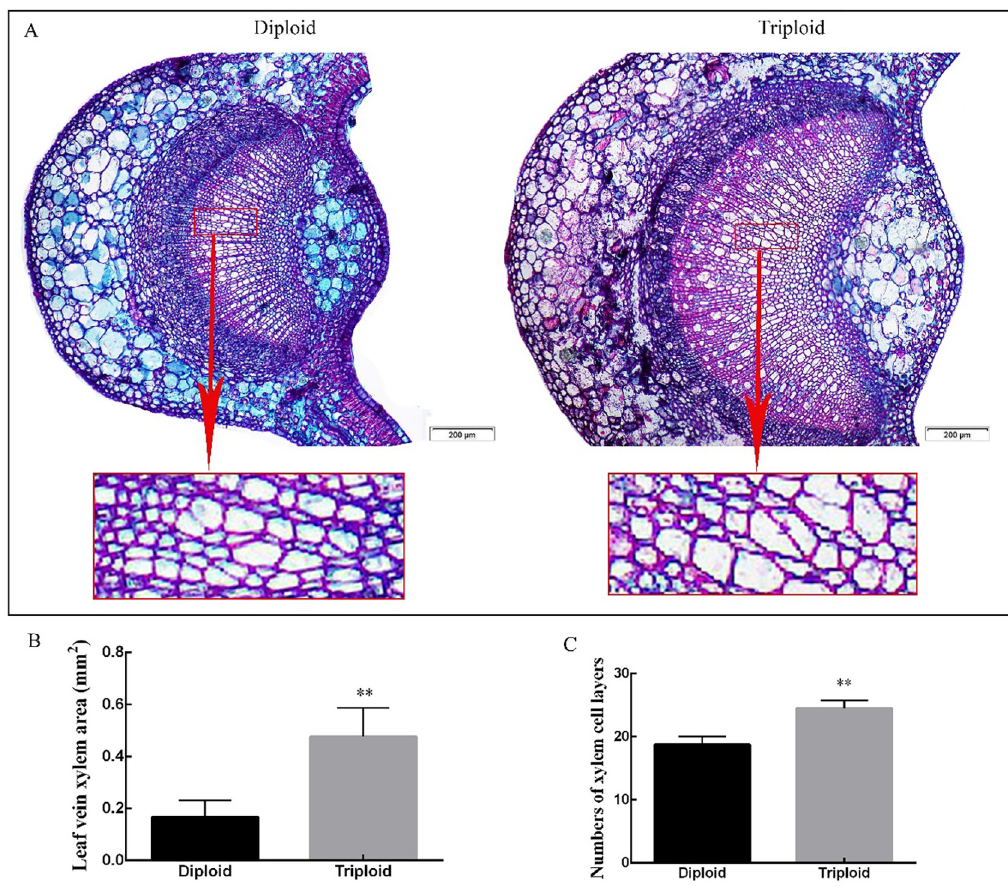
Fig 2. Transverse section of tea diploid and triploid leaf veins. A: Diploid and triploid vein xylem cross section under 50X magnification. B&C: Statistical data for cross sections of diploid and triploid leaf vein xylem blades. Error bars indicate SD (n = 3); �� indicates significant difference at the 0.01 level between the diploid and